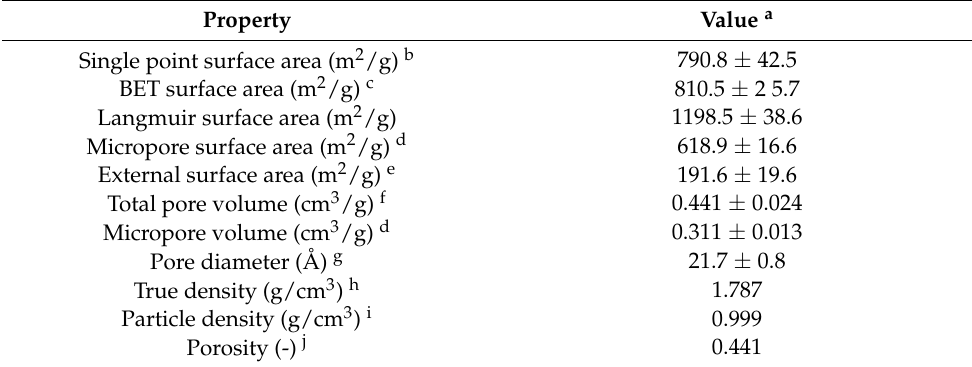
Table 1. Pore properties of resulting activated carbon (WCH-AC).